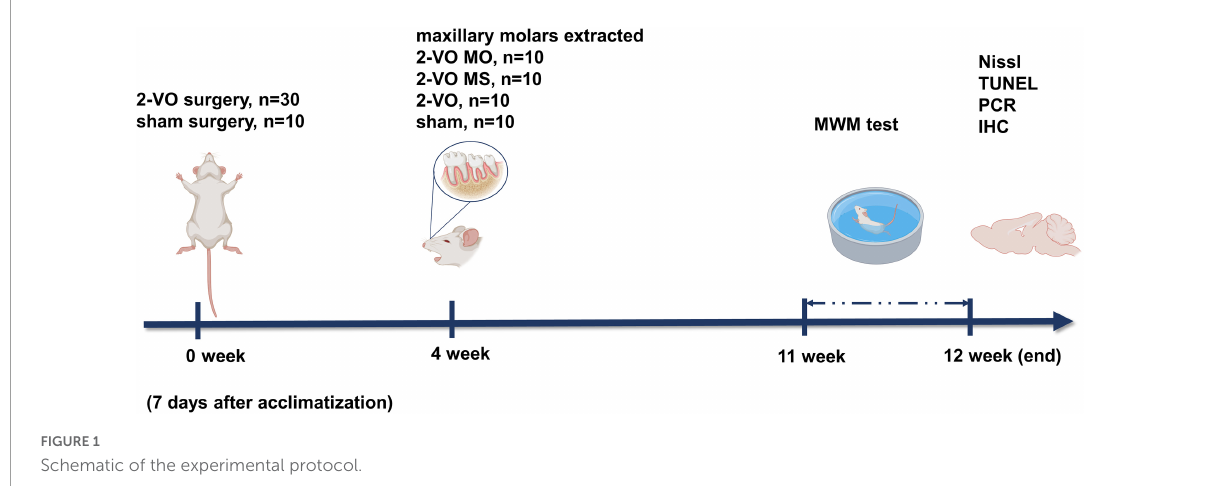
FIGURE1 Schematic of the experimental protocol.